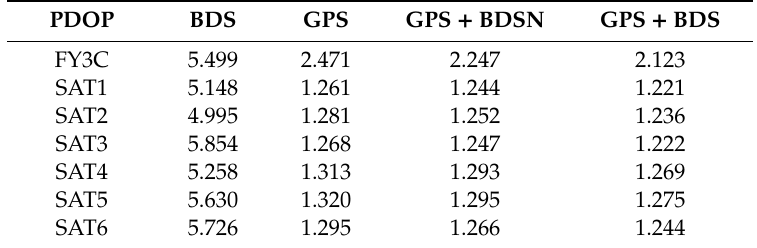
Table 4. Comparison of position dilution of precisions (PDOPs) for di ff erent GPS / BDS